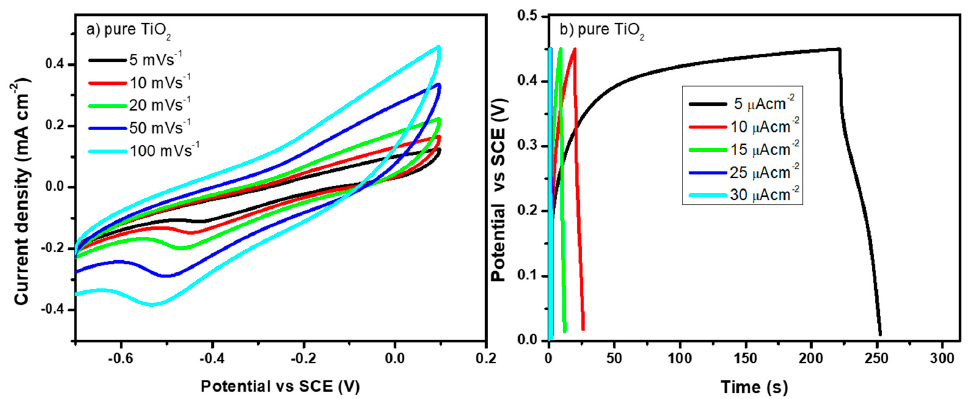
Figure 6. ( a ) CV curves of pure TiO 2 electrode measured at various voltage sweep rates and ( b ) GCD curves of pure TiO 2 electrode measured at various current densities.